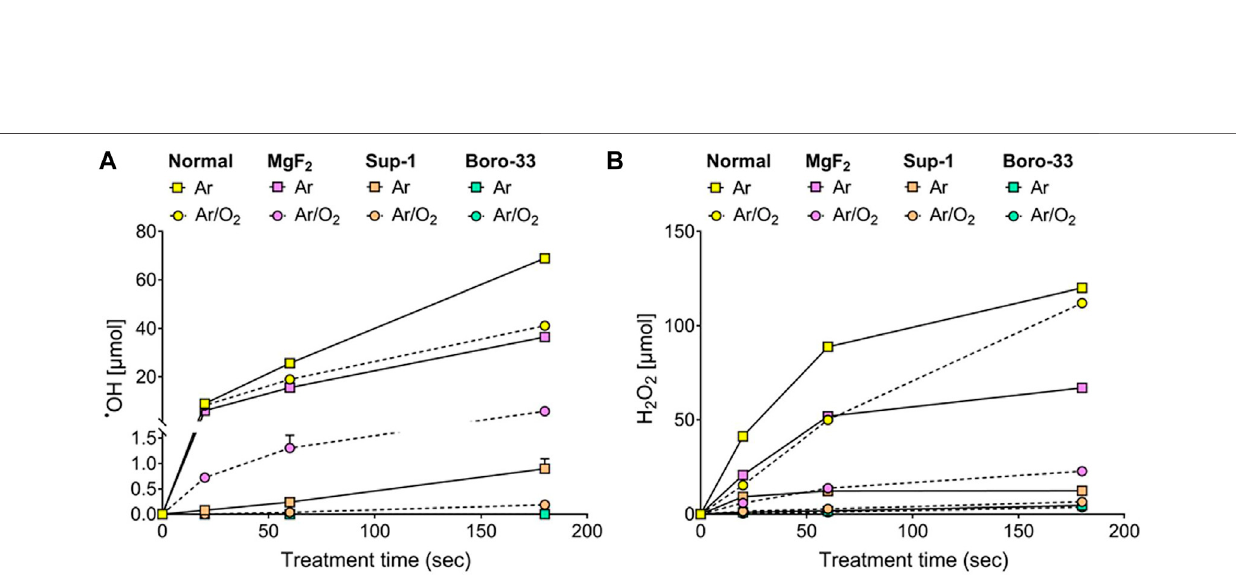
Frontiers in Physics |